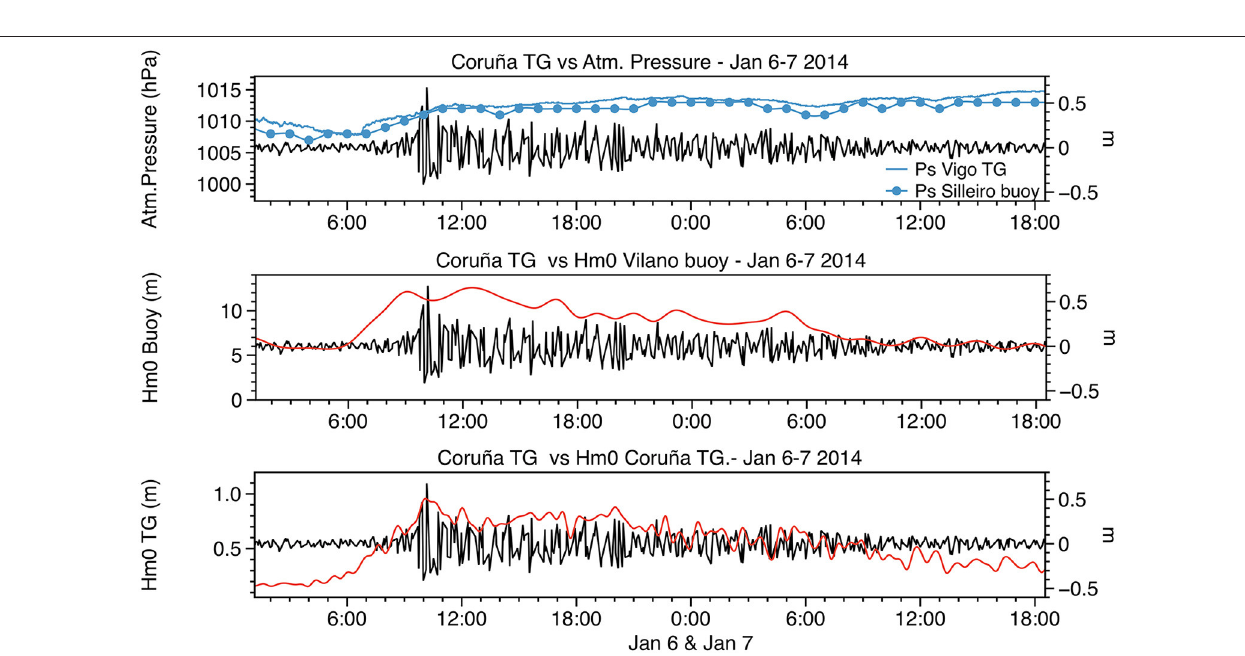
Frontiers in Marine Science | www.frontiersin.org